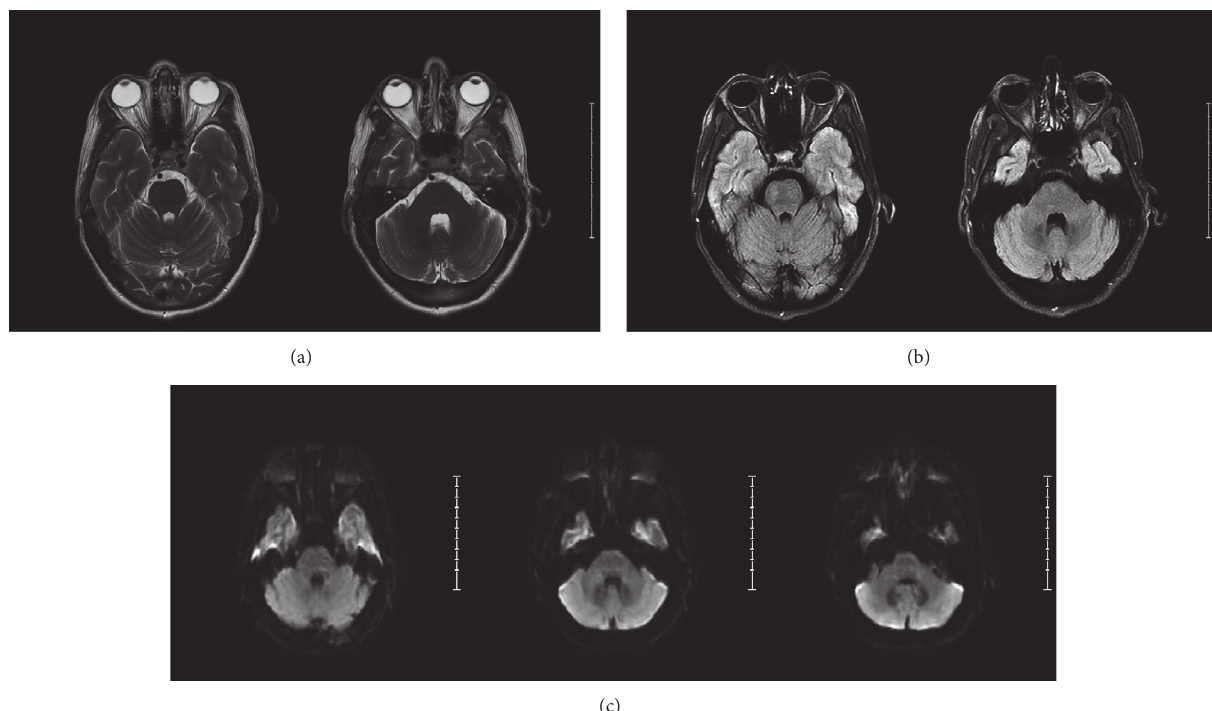
Figure 3: MRI obtained on hospital day 5. T2-weighted images (a), FLAIR (b), and DWI (c) showed no evidence of intracranial